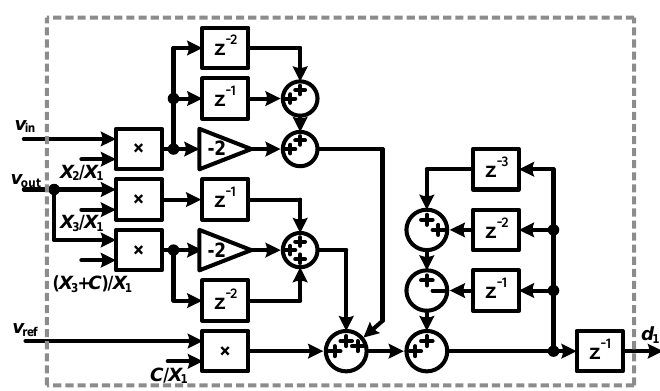
Figure 5. Simplified implementation of the proposed linearized discrete charge balance (LDCB) controller.